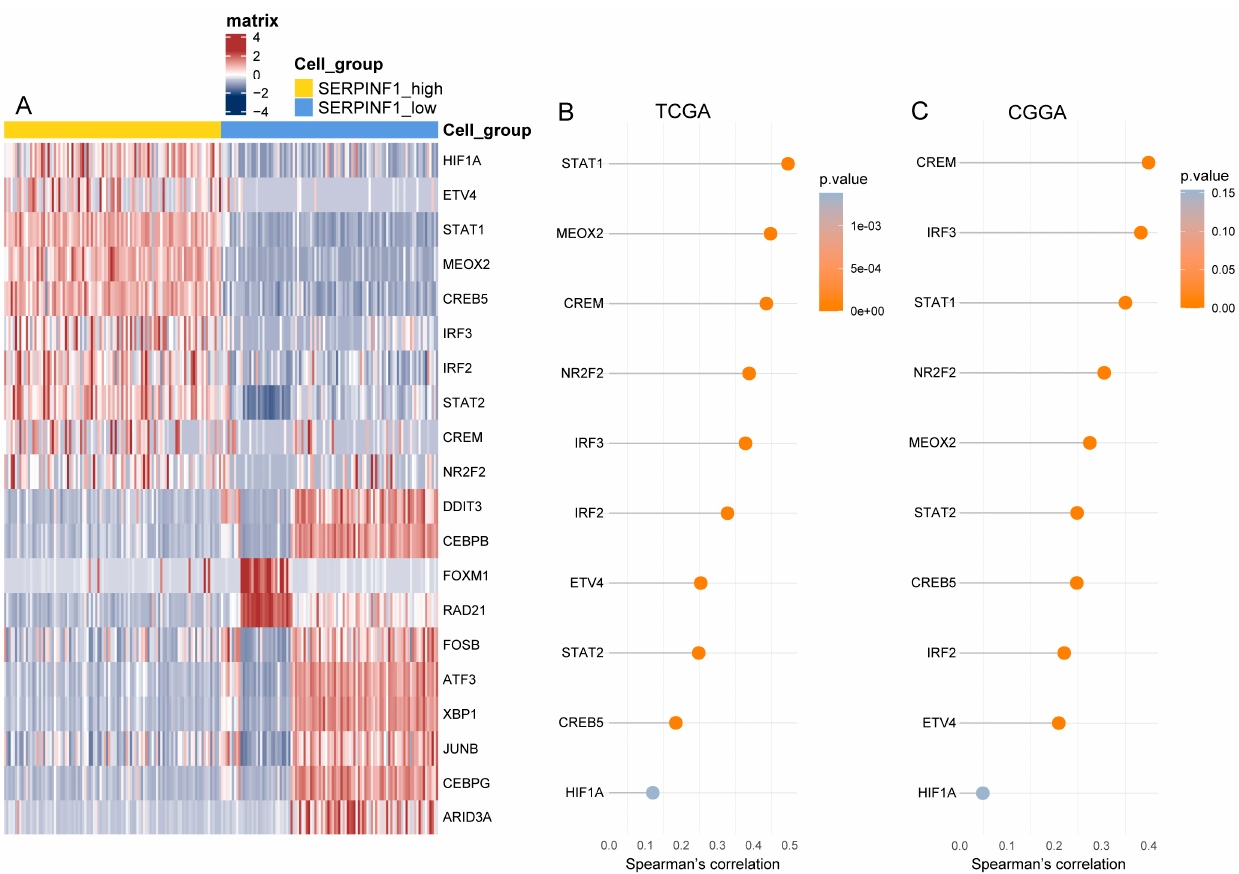
Figure 7. Transcriptional regulation of SERPINF1 in glioma. ( A ) Heatmap of TF activity via SCENIC at the single-cell level. The correlations between the expression of TFs and that of SERPINF1 verified via RNA-seq data of gliomas in TCGA ( B ) and CGGA ( C ).